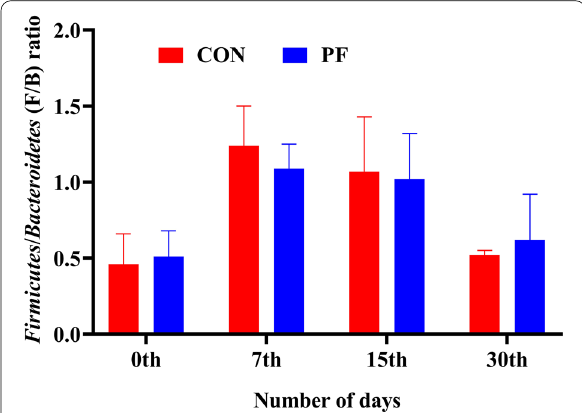
Fig. 6 The ratio of Firmicutes / Bacteroidetes (F/B) in the feces of Murrah buffalo calves supplemented with probiotics as compared to control group. Basal diet with no supplementation (CON), supplemented with L. reuteri BF-E7 L. salivarius BF-17 (PF; 1 +